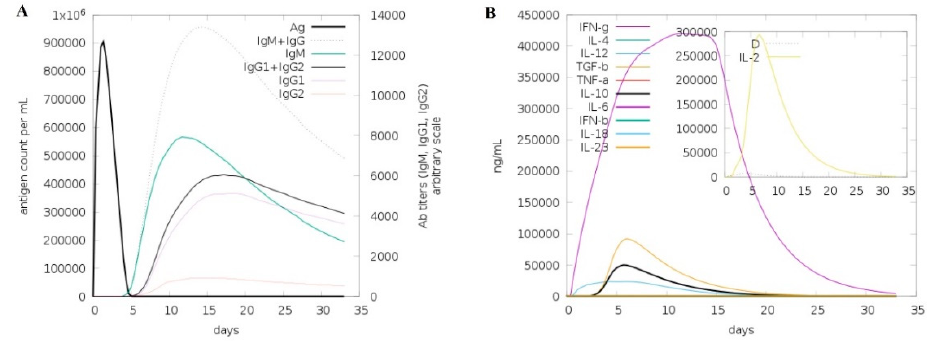
Figure 5. Computational immune simulation by C-Immsim using MVC as antigen. ( A ) Immunoglobulin / antibodies titer in response to antigen injection. ( B ) Production of interleukin (IL) and cytokines in response to antigen.